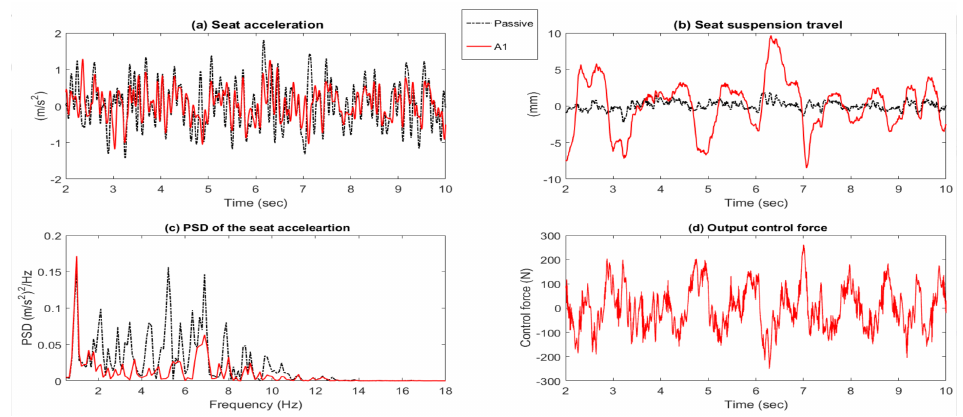
Figure 14. Time responses and PSD of the passive system and active seat suspension with controller A1.